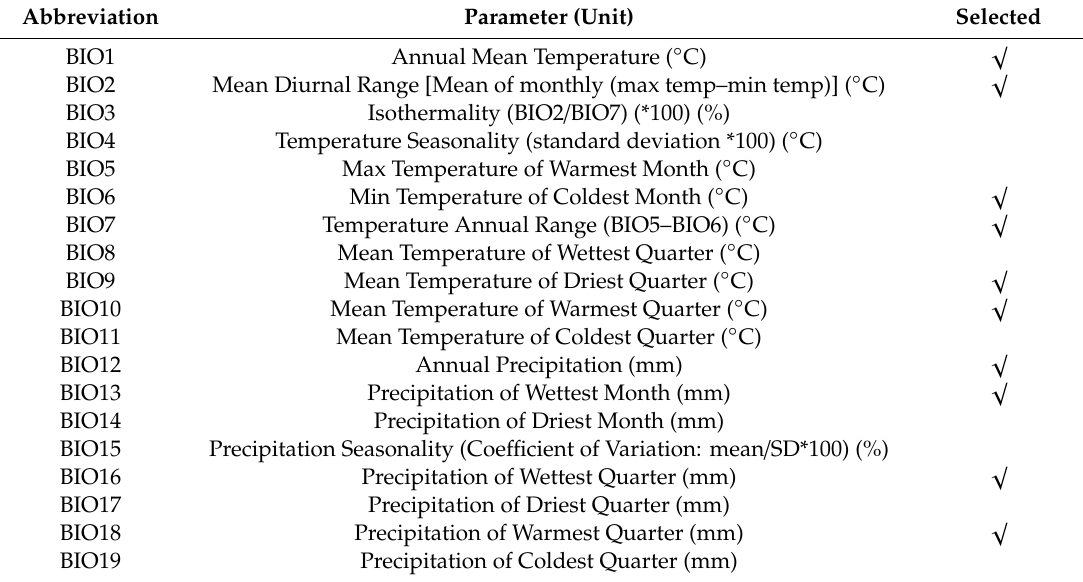
Table 1. Overview of bioclimatic variables used in this